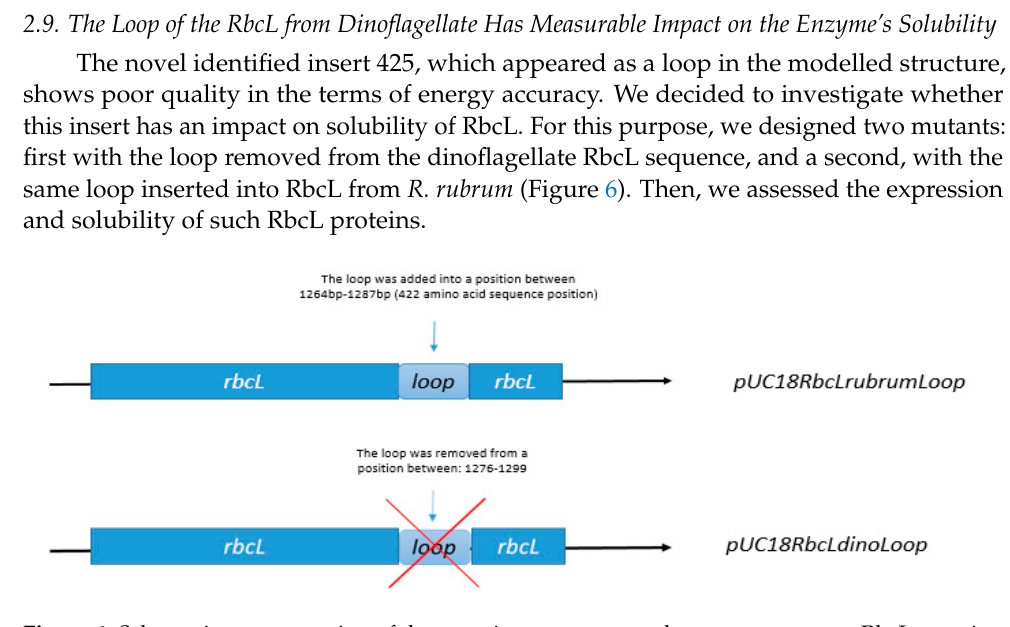
Figure 6. Schematic representation of the genetic constructs used to express mutant RbcL proteins: the 425 insert loop was removed from rbcL coding sequence of Symbiodinium sp. or added to rbcL coding sequence of R. rubrum .